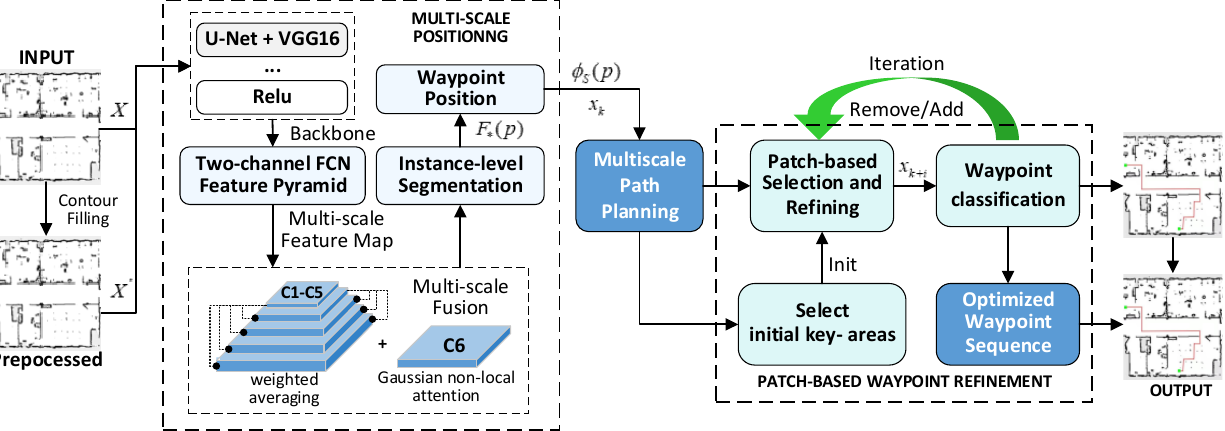
Figure 2. The framework of the proposed HDPP.